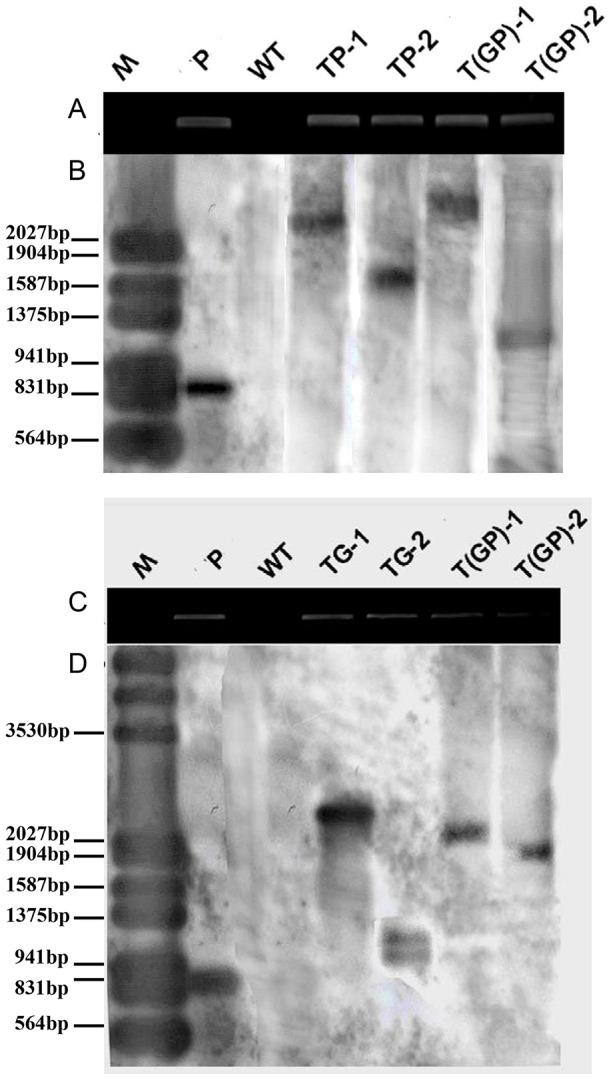
DNA fingerprinting to confirm the presence of PaPCS (A,B) and PaGCS (C,D).(A,C) PCR analysis, (B,D) Southern blot hybridization of EcoRI and SacI digested genomic DNA. TP-1, TP-2: carriers of PaPCS; TG-1, TG-2: carriers of PaGCS; T(GP)-1, T(GP)-2: carriers of PaGCS-PaPCS; P: plasmid; WT: wild type F. arundinacea. M: size marker.